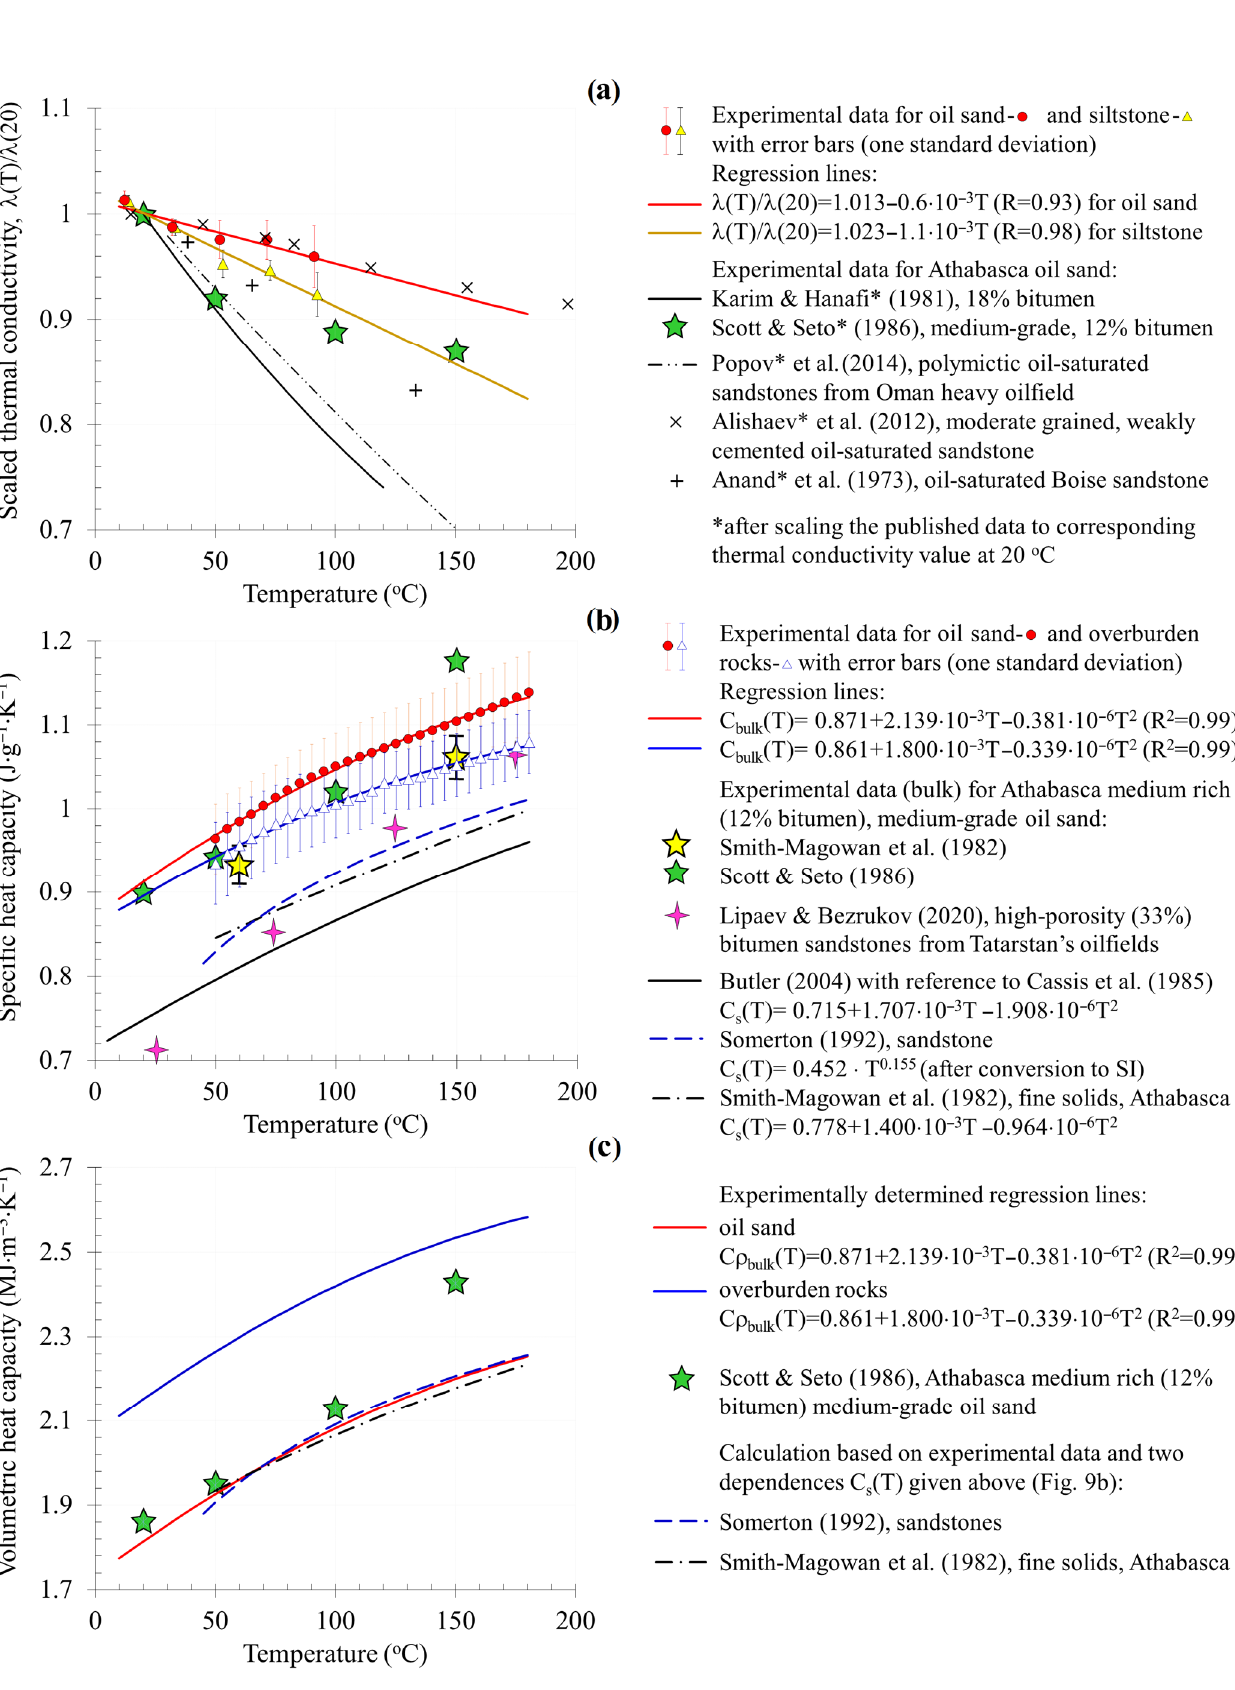
Figure 8. ( a ) The normalized thermal conductivity as well as the ( b ) specific and ( c ) volumetric heat capacity of Karabik- ulovskoye field rocks in the temperature range from 8 to 180 °C and comparison with previously published data (see comments in the text).